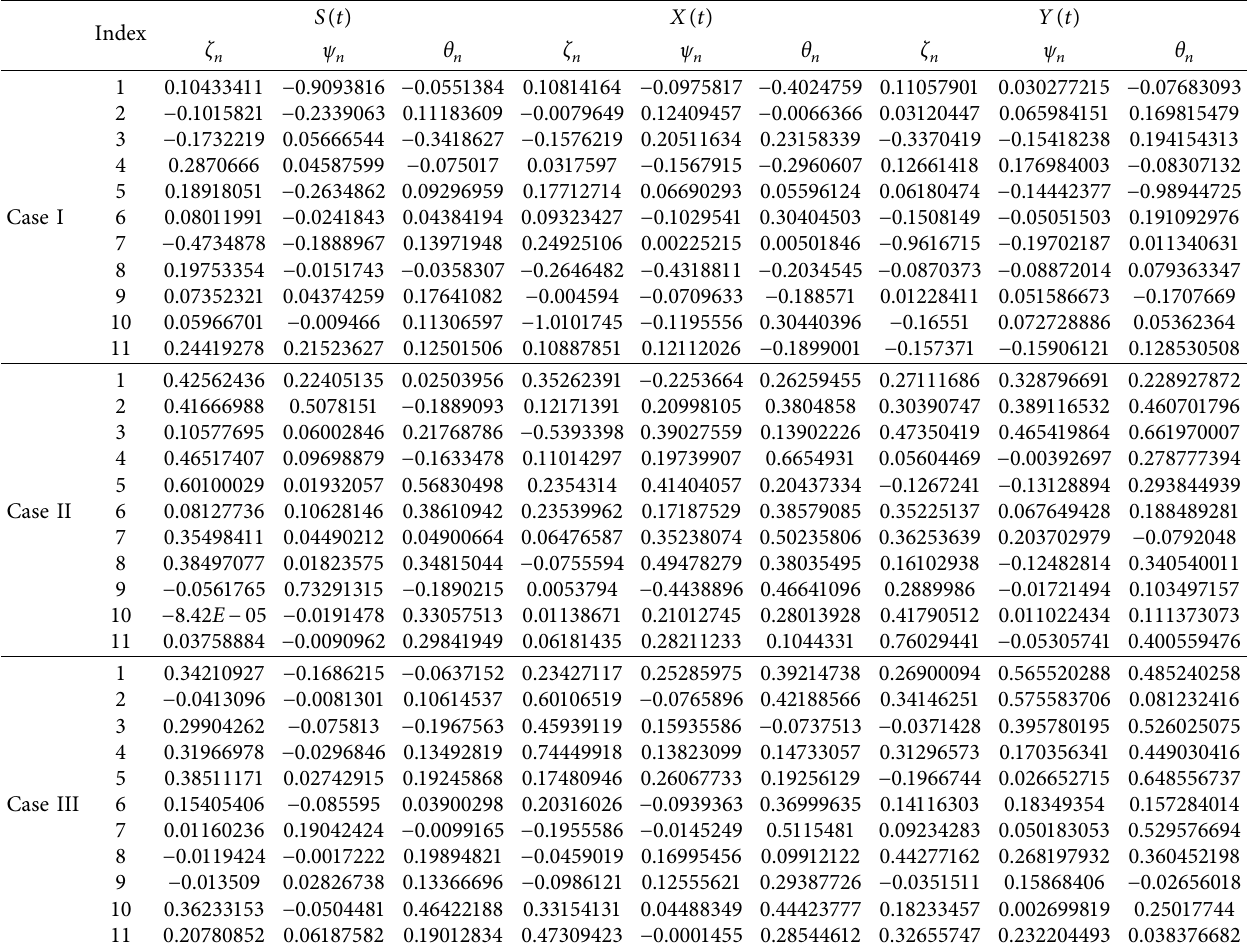
Table 38: Unknown parameters obtained by the LeNN-WOA-NM algorithm for the prey-predator model under the influence of variations in c 1